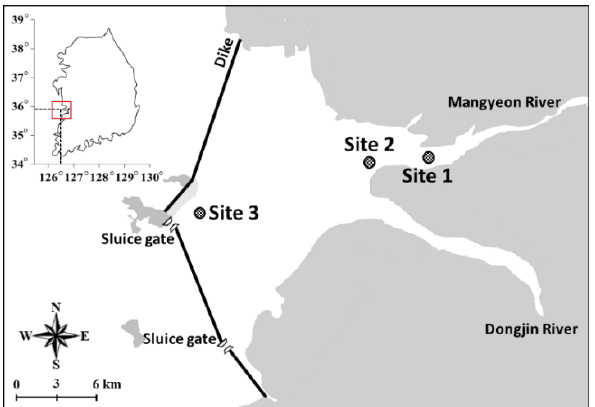
Figure 1. Study sites within the Saemangeum reservoir: the Mangyeong River mouth (Site 1), the point of maximum freshwater inflow to the reservoir (Site 2), and a site close to the northernmost sluice gate (Site 3).